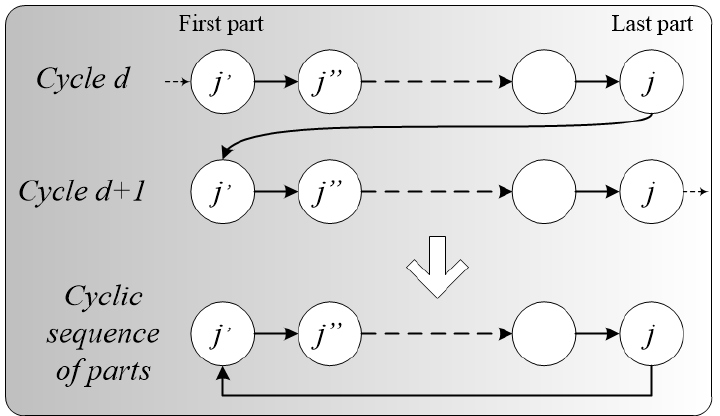
Figure 10. The cyclic sequence of parts on any